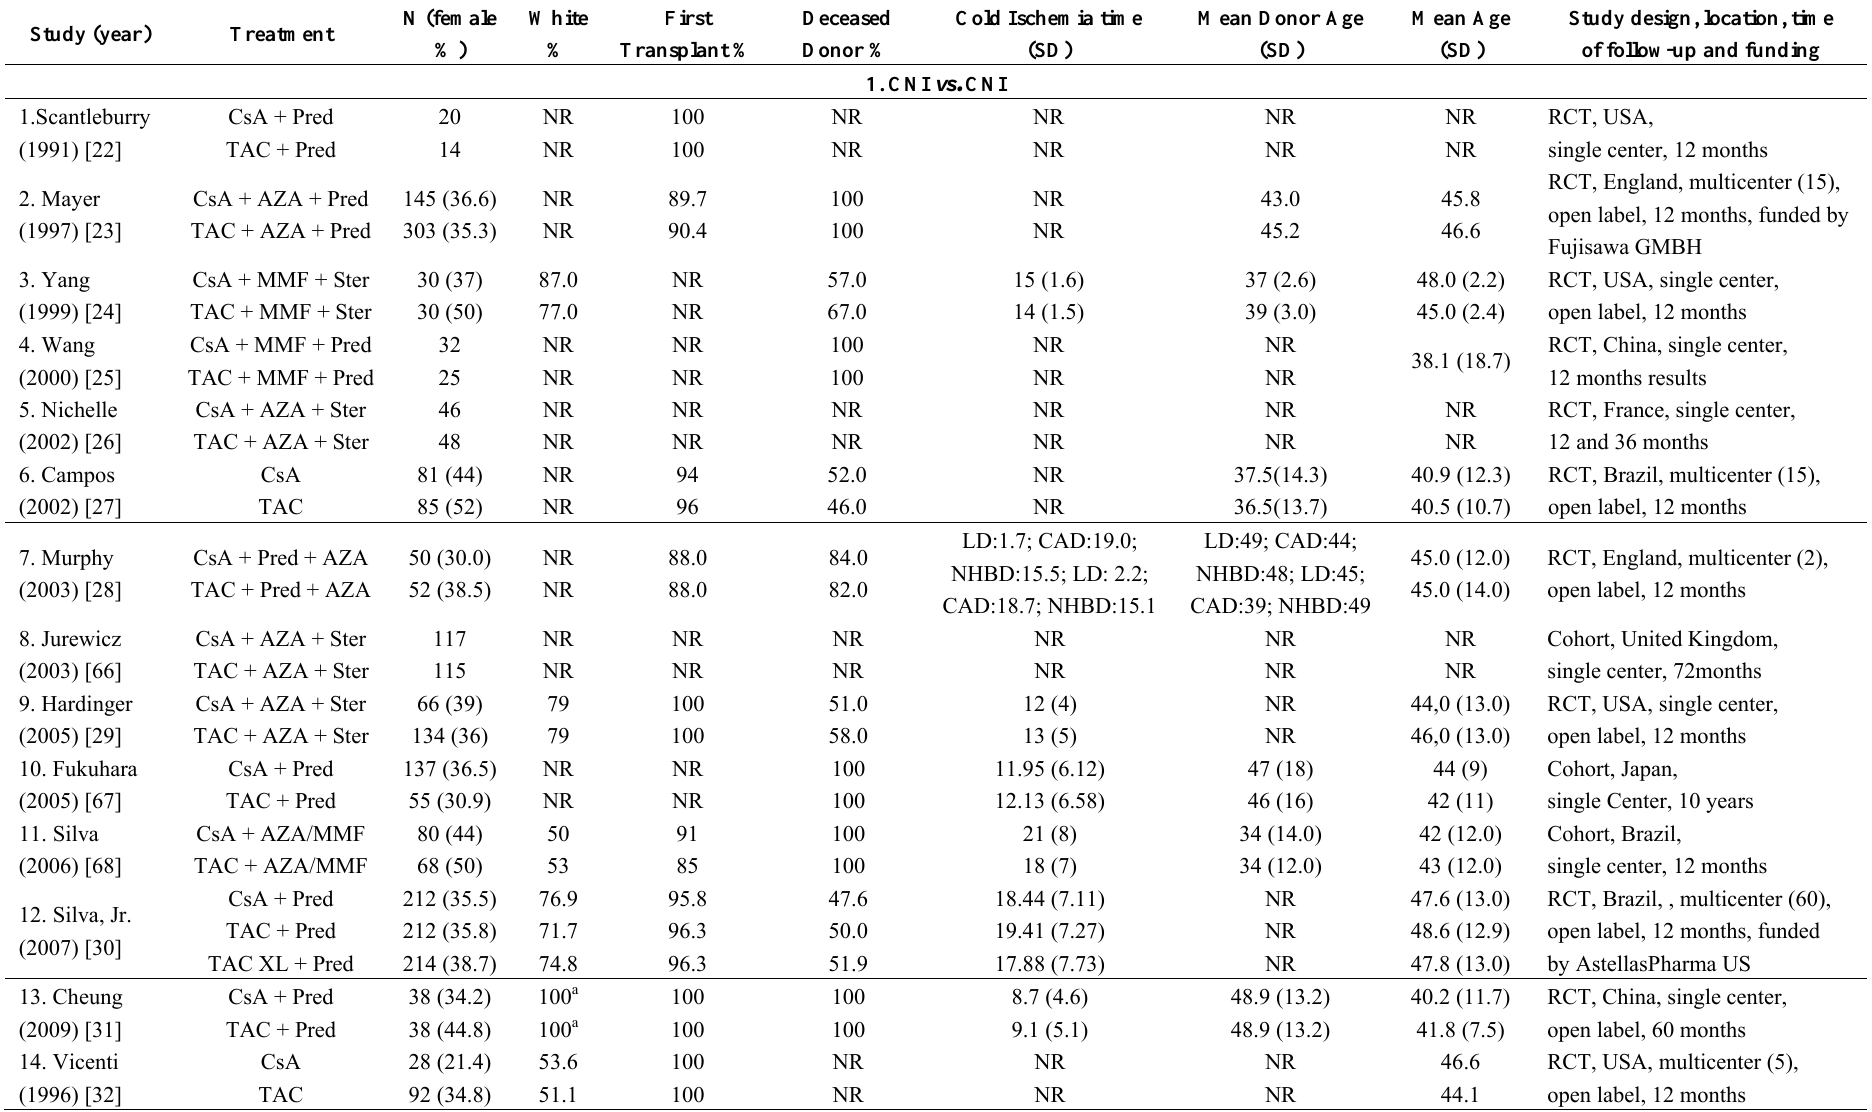
Table 1. Characteristics of included